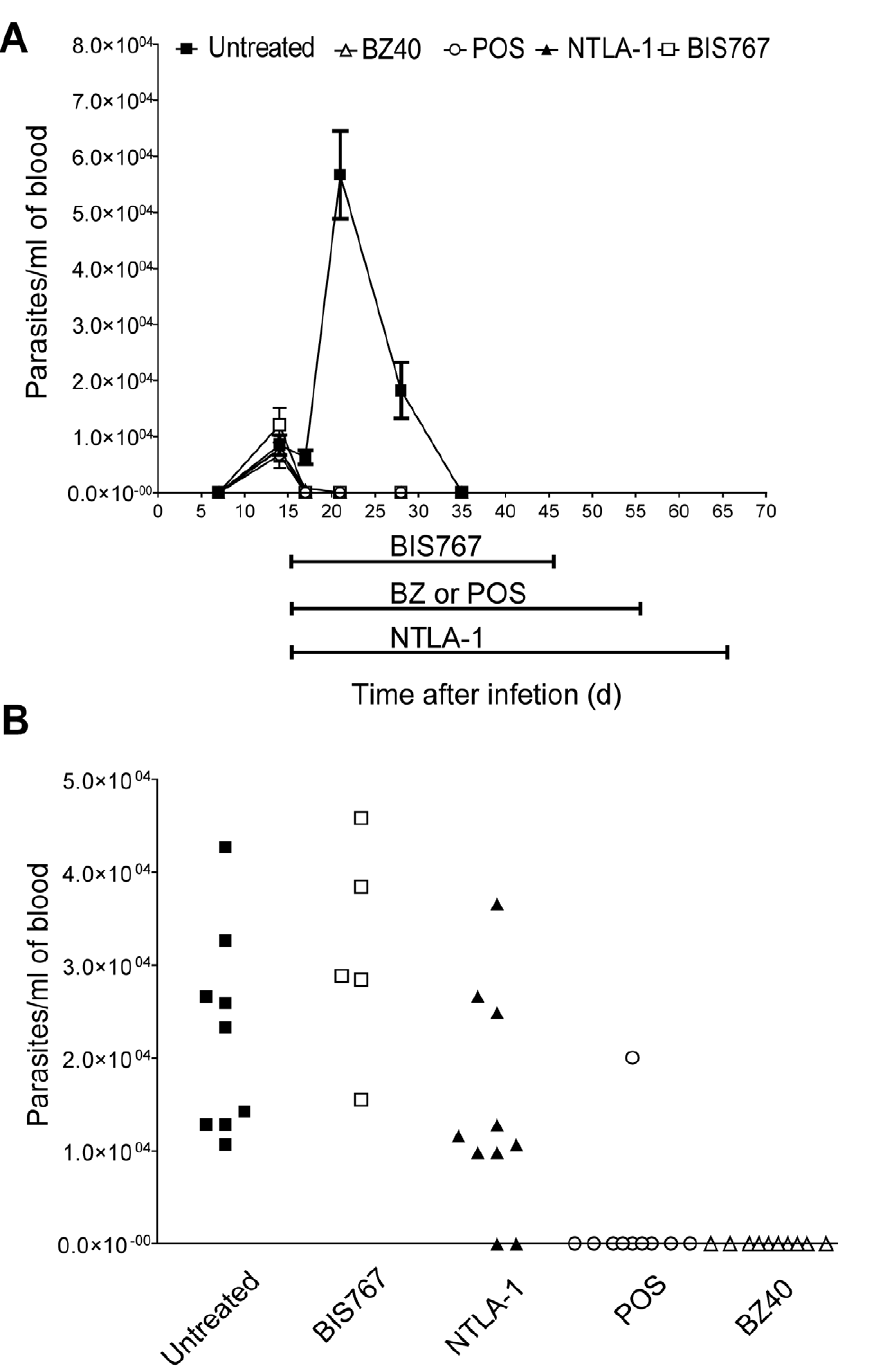
Figure 7. Rapid suppression of parasitemia following drug-treatment is a poor indicator of drug efficacy and parasitological cure. (A) Evolution of parasitemia after infection with 1 6 10 3 CL strain of T. cruzi on day 0 in untreated ( & ), BZ-40 ( n ), POS ( # ), NTLA-1 ( m ), or BIS767 ( % ) treated mice. ‘‘BIS767, BZ-40, POS and NTLA-1’’ bars below x axis indicate period of treatments. (B) Parasitemias in untreated or treated mice at 120dpi, after administration of the immunosuppressant cyclophosphamide (cy) (days 105, 108, 111, 113 and